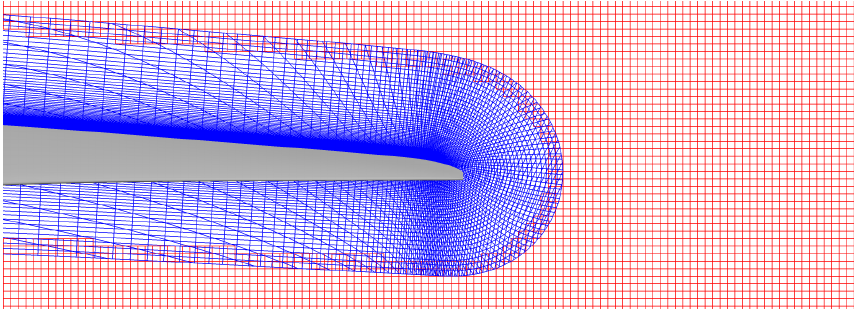
Figure 2. Close-up view of a slice of the Helios overset mesh system. The near-body volume mesh, whose solution is computed by mStrand, is colored blue and body-fitted around the grey APC rotor. The off-body volume mesh, colored in red, is structured in nature and solved by SAMCart. The solution in the overlap region is automatically